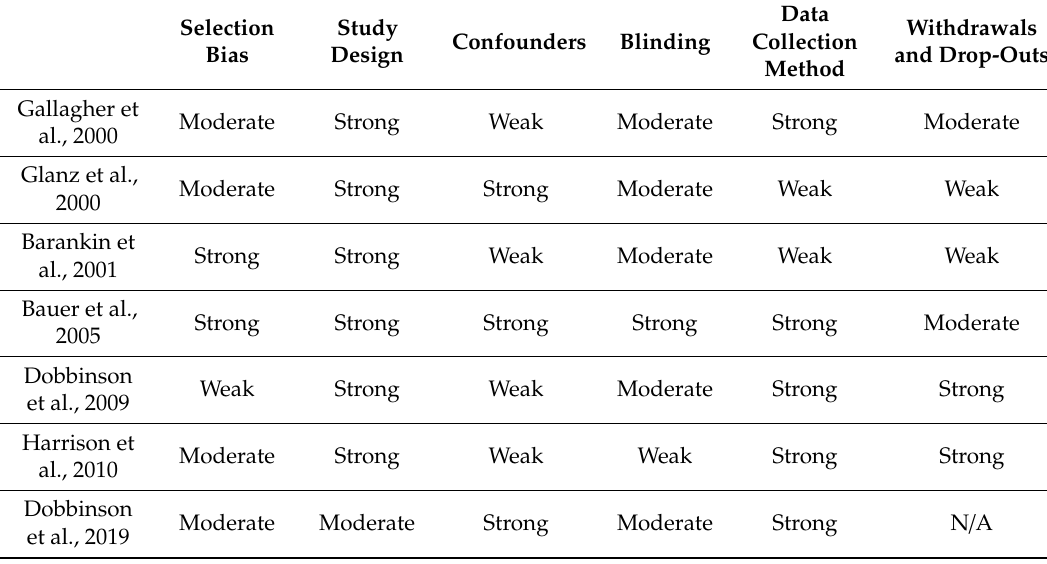
Table 4. Study quality of included studies in the systematic review